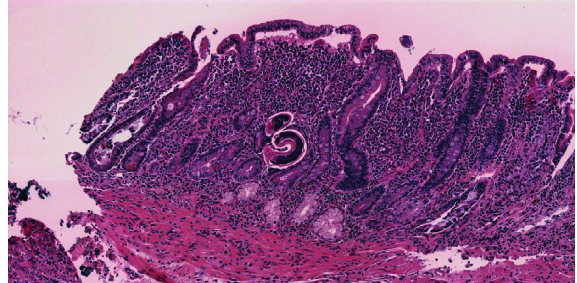
Figure 2: H&E stain of gastric mass showing the nematode and inflammatory